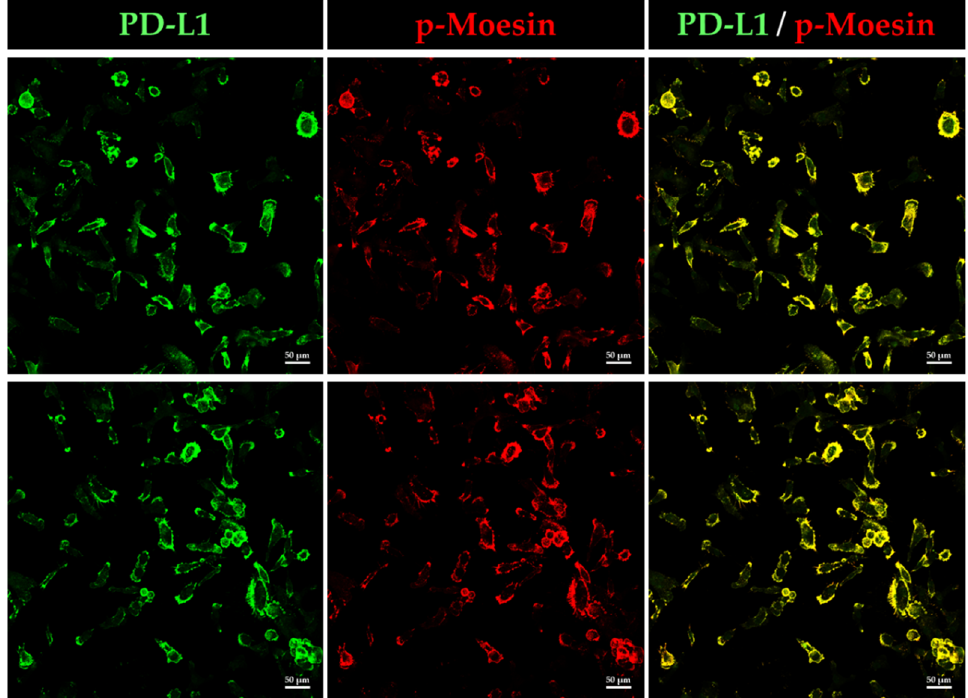
Figure 6. Phosphorylated moesin (p-moesin) colocalizes with PD-L1 in BOKU cells. Subcellular localization of p-moesin and PD-L1 in BOKU cells as observed by CLSM. PD-L1 labeled with Alexa Fluor 488 (green) was highly colocalized on the plasma membrane with p-moesin labeled with Alexa Fluor 594 (red). Scale bars: 50 µm. Data are representative of at least three independent experiments.